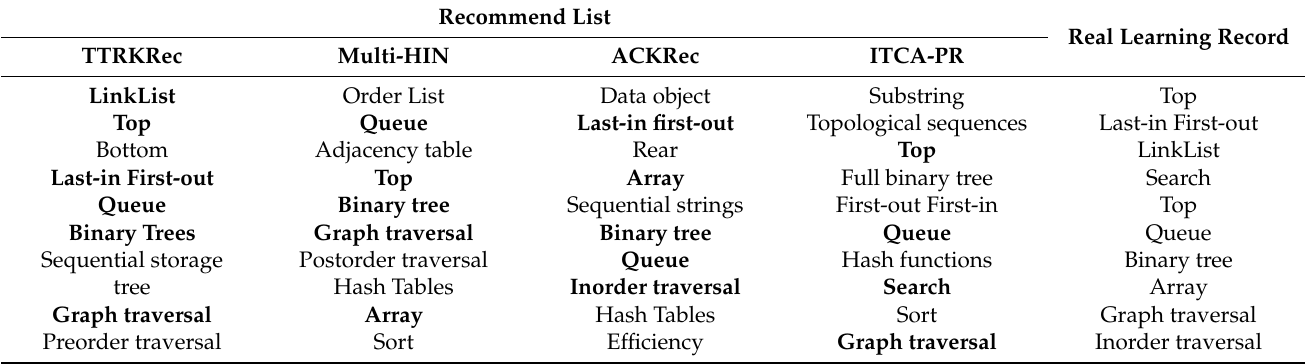
Table 5. List of recommendations under di ff erent recommendation models for student U_6325216.